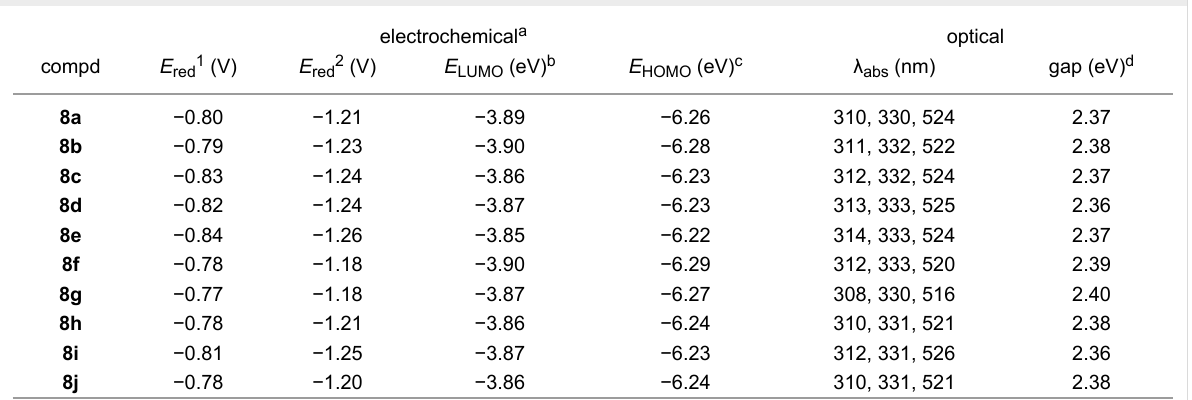
Table 2: Electrochemical and optical data for ID-diones 8a–j